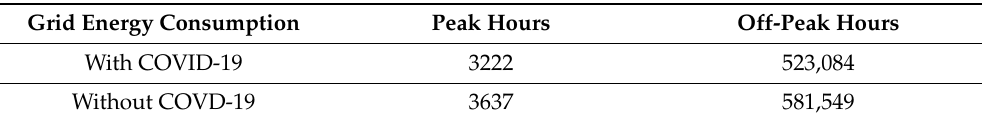
Figure 4. Monthly grid energy consumption (MWh) during peak and off-peak hours [42] and monthly power demand (kW) with [42] and without [24] pandemic scenario. Table 3. Annual grid energy consumption (kWh/year) with and without pandemic scenario (rows) during peak and off-peak hours (columns).